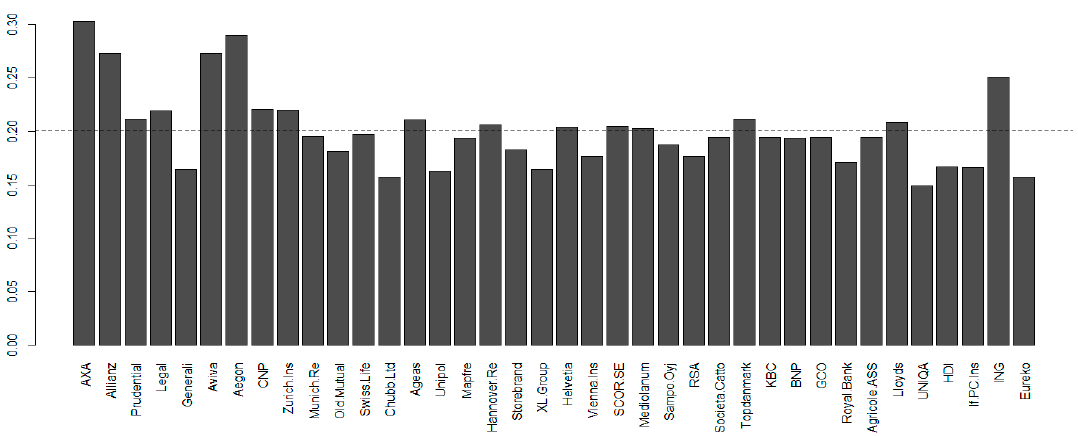
Figure 4. Average closeness centrality in the period under consideration. Source: Own study.